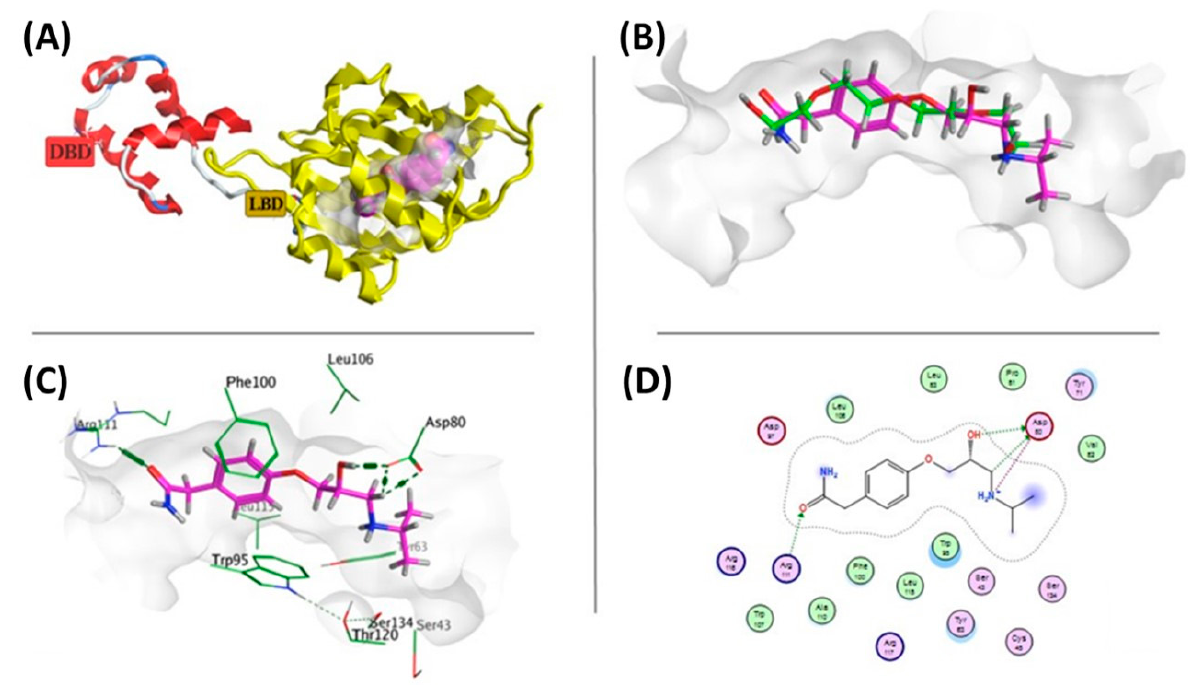
Figure 7. ( A ) Three-dimension cartoon representation of E. coli SdiA; Ligand-Binding Domain (LBD) is in yellow color and DNA-Binding Domain is in red color ( B ) Superimposition of TEG and atenolol in the molecular surface of the active site; Atenolol is represented in purple and TEG in green. ( C ) Three-dimension Atenolol- E. coli SdiA interaction diagram. Atenolol is in thick purple sticks within the molecular surface of the active site, amino acid residues of the active site are shown as thin green sticks. H-bond is presented as green dots. ( D ) Two-dimension Atenolol- E. coli SdiA interaction plot.